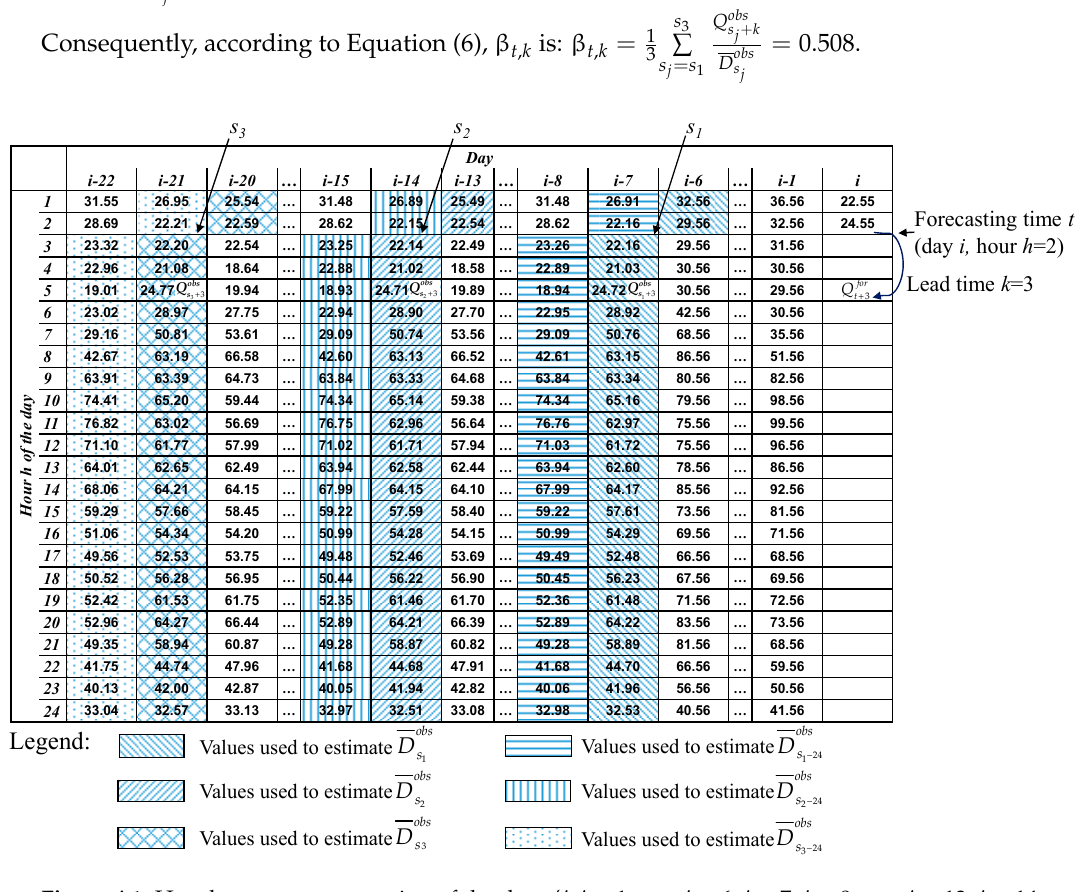
β and at the forecasting time t considering a t , t k